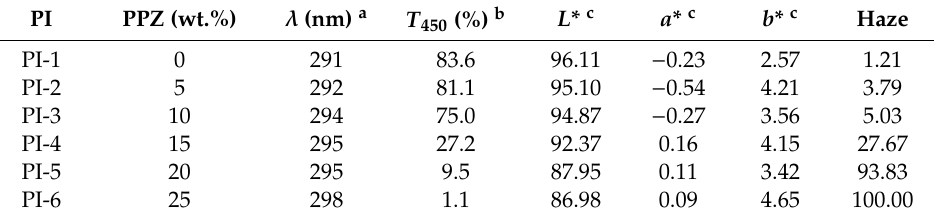
Table 1. Optical properties of PI films.